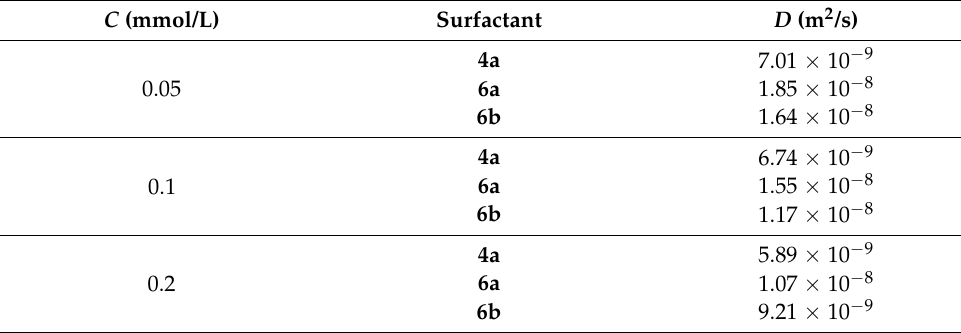
Table 4. Diffusion coefficients of 4b and 6c